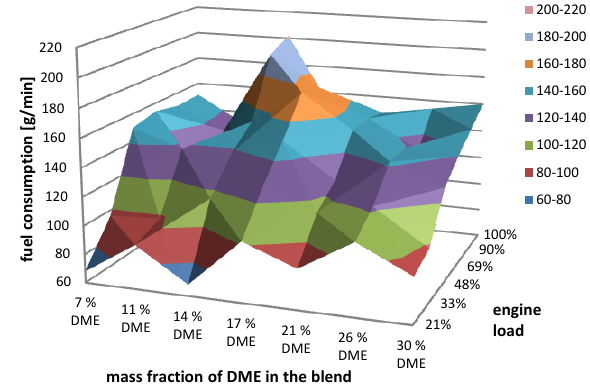
Fig. 3. Fuel consumption [g/min] depending on the percentage of DME and engine load, no correction of the spark advance angle